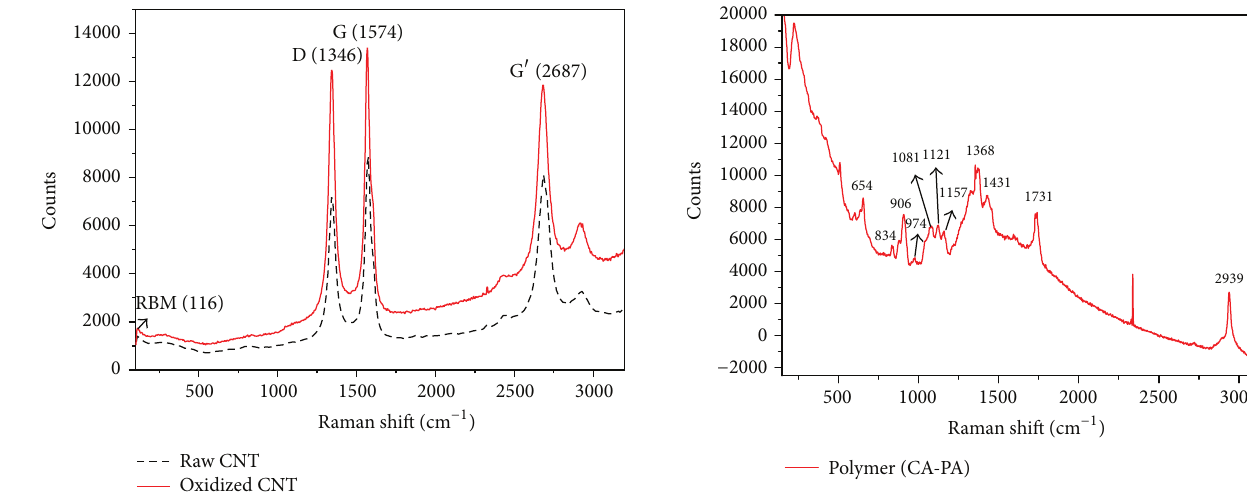
bonds present in the rings at 1265 cm −1 . The characteristic Raman signals for the acetyl group can be observed at 1736, 1435, and 1382 cm −1 corresponding to vibration of the carbonyl group (C=O) and asymmetric and symmetric vibra- tions of the C-H bond present in the acetyl groups. The signals observed at 978, 906, 834, and 659 cm −1 can be associated with C-O, C-H, O-H, and C-OH bonds, respectively. The spectrum for the polyacrylic acid is shown in Figure 6. The characteristic Raman signals can be observed at 3444 and 1678 cm −1 corresponding with the oxygen- hydrogen bond vibration and carbonyl group (C=O) vibra- tion present in the carboxylic groups. The stretching vibra- tions of the carbon-carbon double bond (C=C) appear at 1654 cm −1 while in-plane bending of the O-H bond can be placed at 1496 cm −1 . Finally, the bands at 1306, 1224, and 905 cm −1 correspond to C-O bond vibrations. The peak at 1224 cm −1 had a contribution from C-C bonds present. When Figure 5: Raman spectrum for cellulose acetate. the polymers (AC and PA) are mixed, the spectrum obtained shows primarily the characteristic Raman signals for cellu- lose acetate while polyacrylic acid has remained undetected because their bands partially overlapped those of cellulose acetate, as shown in Figure 7. The characteristic Raman sig- nals for polymer (PA-AC) were present at 2939 and 1121 cm −1 , which are attributed to C-H stretching and asymmetric stretching vibration of the C-O-C glycosidic linkage, respec- tively. In addition, we observed the pyranose ring signal at 1081 cm −1 and the characteristic Raman signals for the acetyl group at 1731, 1431, and 1368 cm −1 corresponding to vibration of the carbonyl group (C=O) and asymmetric and symmetric vibrations of the C-H bond present in the acetyl groups, respectively. Finally, the signals observed at 978, 906, 834, and 659 can be associated with C-O, C-H, O-H, and C-OH bonds, respectively. For the polymer (CA-PA), we cannot observe the band associated with the C-OH bonds present in the glycosidic rings at 1265 cm −1 and we cannot see the characteristic Raman signals at 3444 and 1678 cm −1 cor- Figure 6: Raman spectrum for polyacrylic acid. responding with the oxygen-hydrogen bond vibration